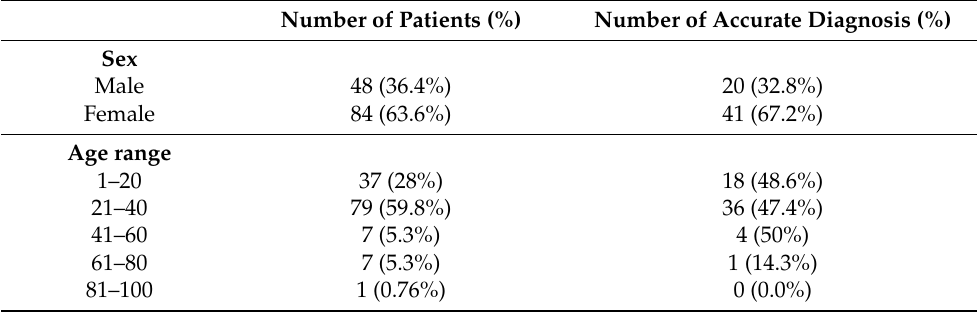
Table 1. Socio-demographic characteristics of the patients and accuracy of the ultrasound diagnosis. Number of Patients